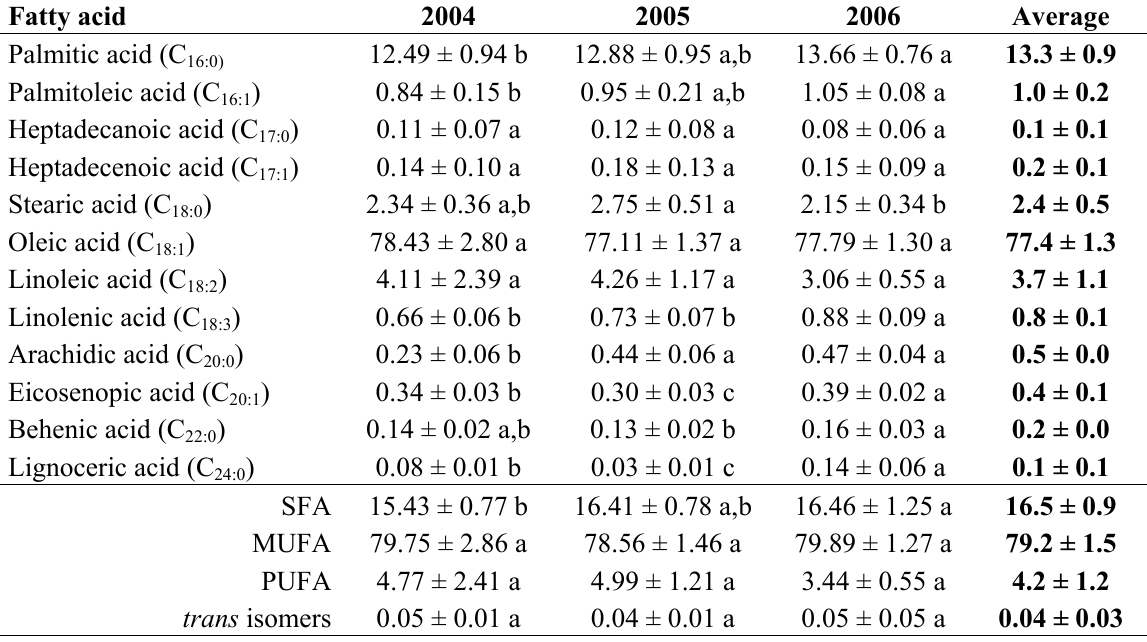
Table 2. Fatty acid composition (percentage of total fatty acids as methyl esters) of oil extracted from “ alcaparras ” stoned table olives samples from three different years of production (mean ±